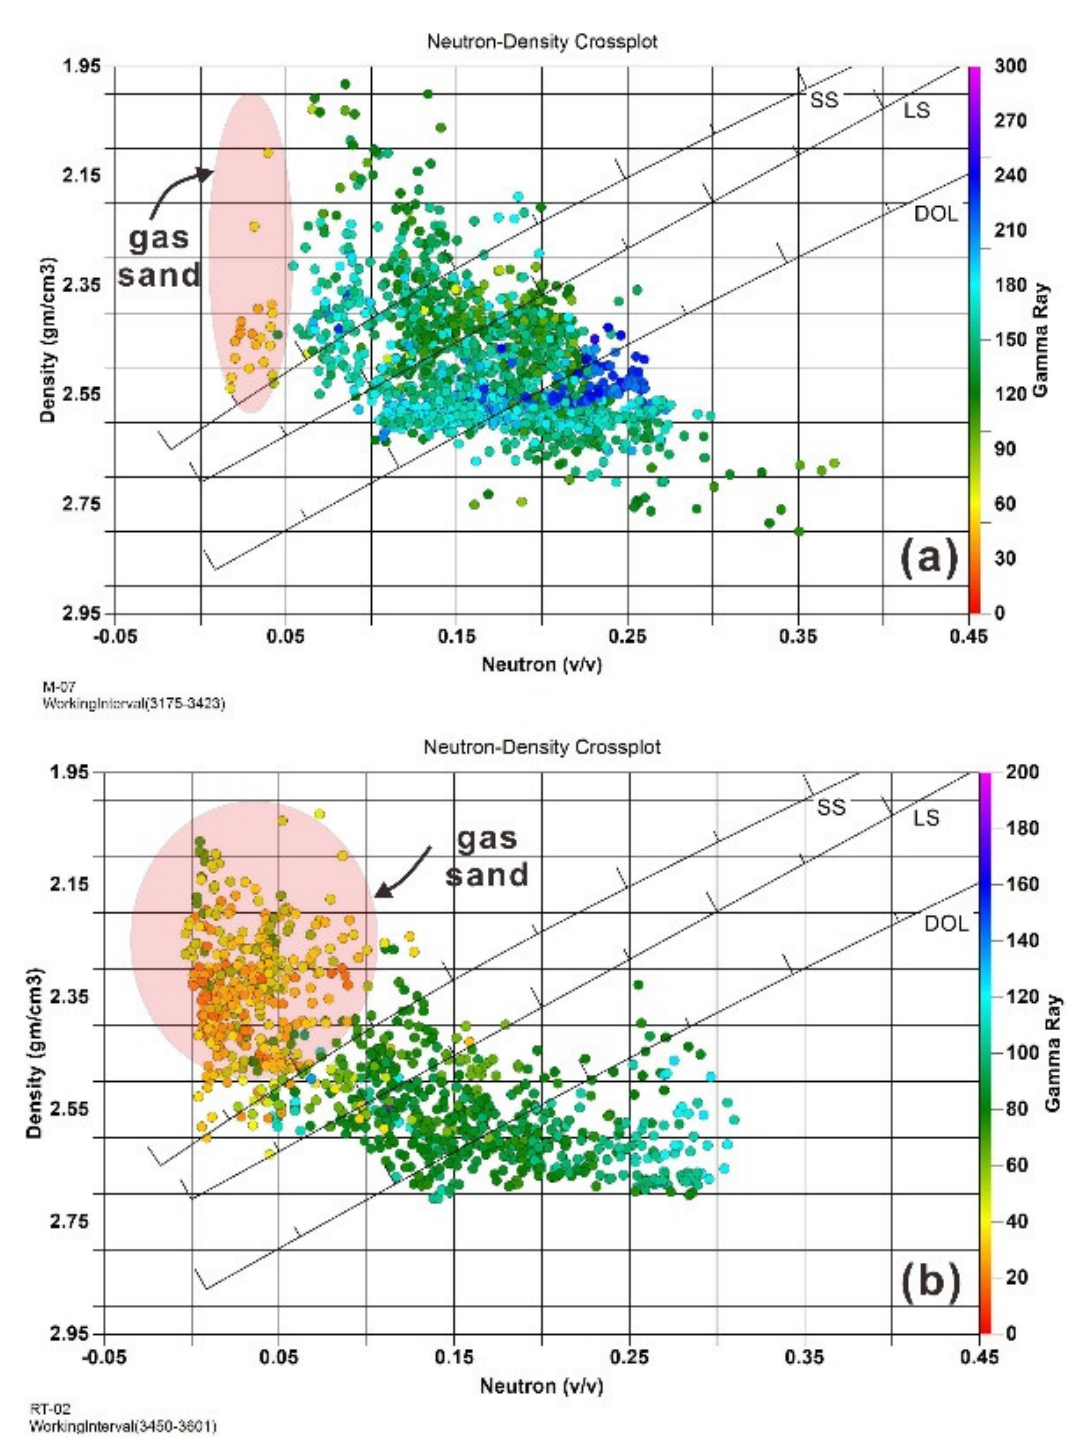
Figure 14. The RPT across RHOB versus NPHI of ( a ) Miano-01 and ( b ) Rehmat-02 wells at the targeted intervals to showcase the gas-saturated (red box), brine sand (green box), and cap shale (blue box)